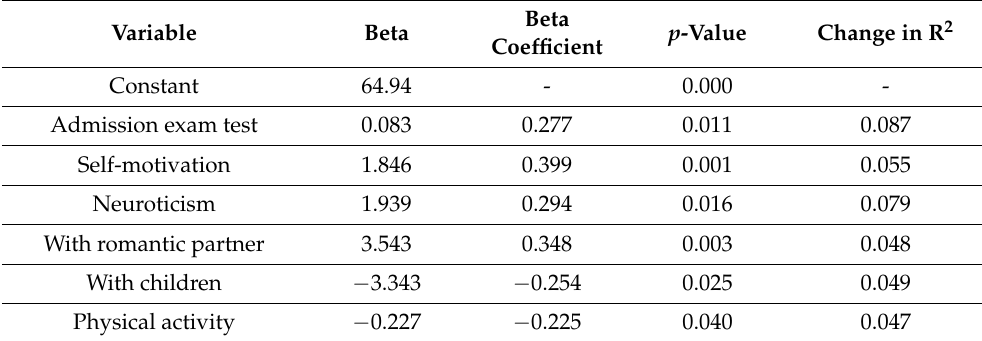
Table 4. Multiple regression analysis for GPA in men. Variable Beta